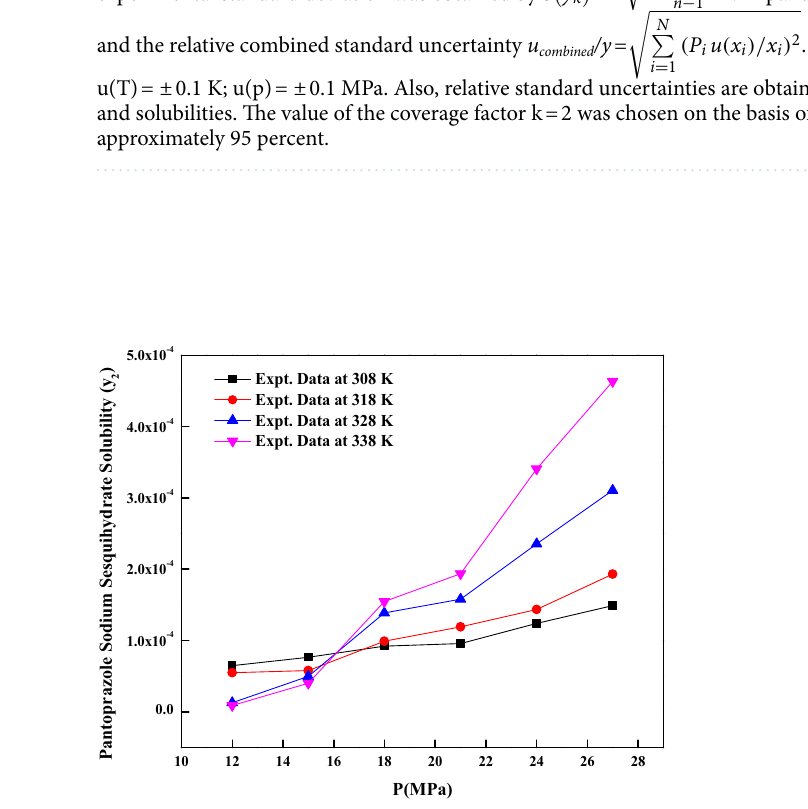
Table 2. Solubility of pantoprazole sodium sesquihydrate in ScCO 2 at various temperatures and pressures. The experimental standard deviation was obtained by S